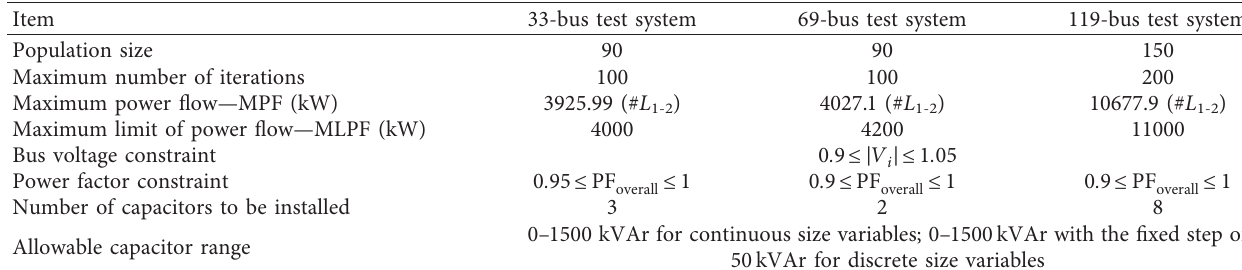
Table 3: Parameter setting for the SQI-SOS algorithm and inequality constraint